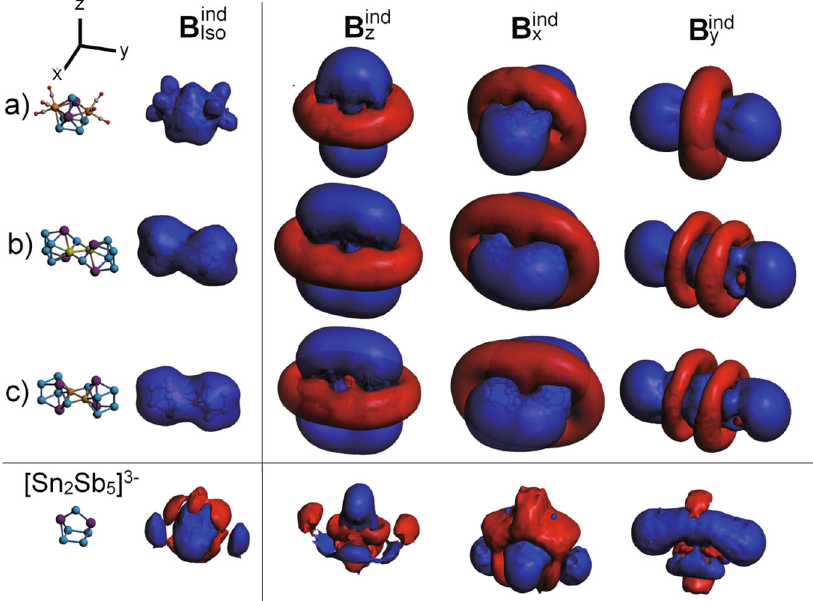
Fig. 5 Plots of magnetic response of the studied clusters. Induced magnetic fi eld accounting for the orientation averaged (B ind iso ) term, and for different orientation of the external fi eld along three representative axes, for a [Mo 2 (CO) 6 Sn 2 Sb 5 ] 3 − , b [(AgSn 2 Sb 5 ) 2 ] 4 − , c [(CuSn 2 Sb 5 ) 2 ] 4 − . Blue surface: Shielding; Red surface: Deshielding. Isovalue set to ±2 ppm. Sn-atoms are dark purple, Sb-atoms are blue, Mo-atoms are orange, Ag-atoms are green, Cu- atoms are dark yellow, C-atoms are gray, and O-atoms are